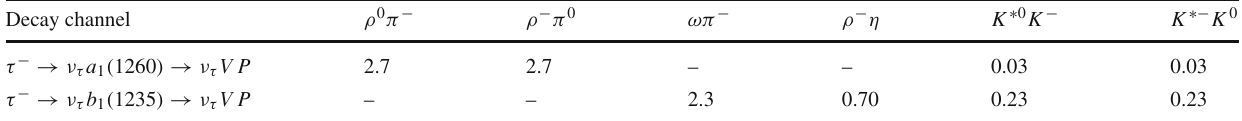
Table 8 Branching ratios (in %) for the (cid:14)(τ → ν τ A → ν τ V P ) process for the I = 1 intermediate axial-vector resonances. The results have an uncertainty of 40% Decay channel ρ 0 π −